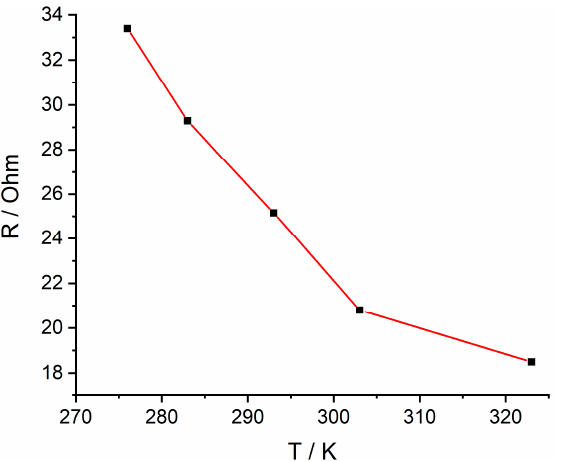
Figure 5. Resistance of 0.1 M HClO 4 solution at di ff erent temperatures in the 1 − 50 °C range.